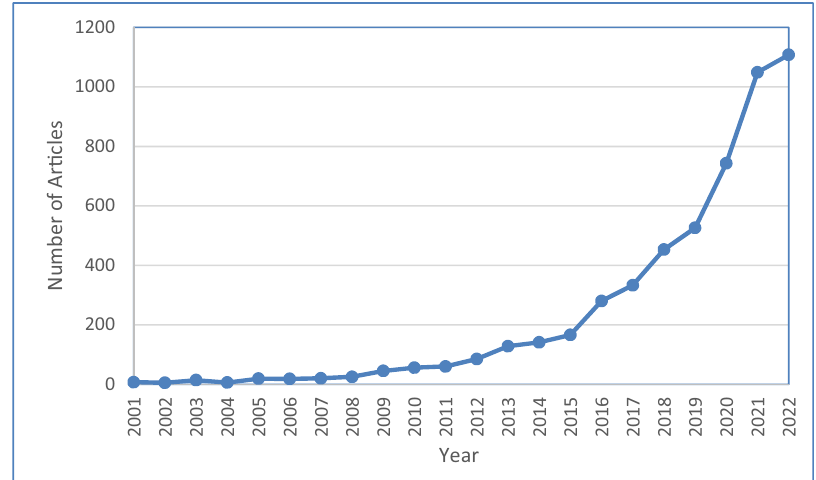
Figure 1: The progress of research on CS - based food packaging published from 2001 to